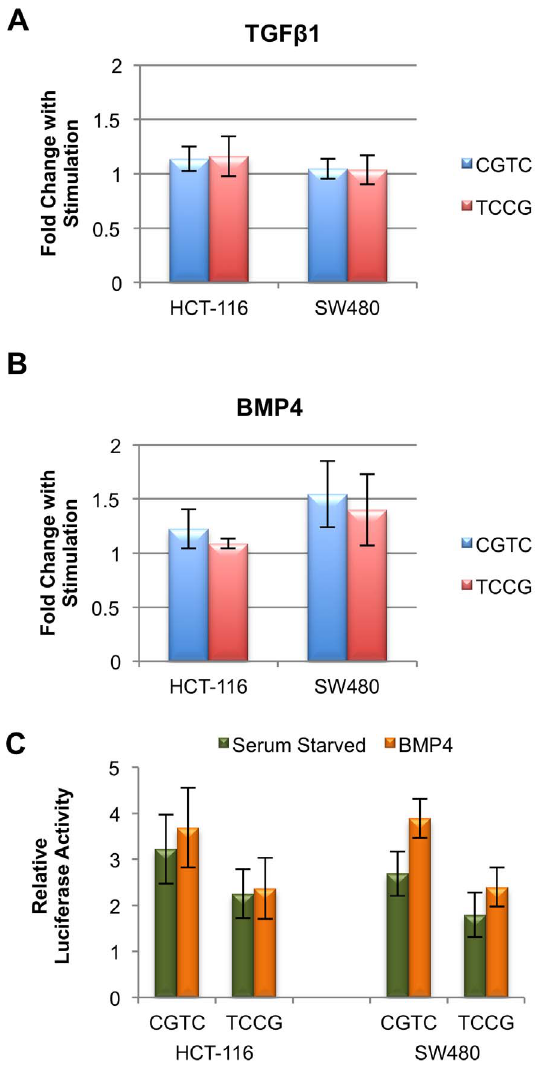
Figure 6. Fragment A Enhancer is responsive to BMP4 stimulation but not TGF b 1. ( A ) Enhancer activity was measured by luciferase assay for the fragment A containing the major (CGTC) and minor (TCCG) haplotypes in serum starved HCT-116 and SW480 cells incubated with TGF b 1 for 6 hours. Samples are plotted as a fold change in activity relative to non-treated cells on the same plate. ( B ) Enhancer activity was stimulated by 6 hours of BMP4 treatment for the CGTC haplotype in HCT-116 ( p = 4.14 6 10 2 3 ) and SW480 cells ( p =1.22 6 10 2 10 ). The TCCG haplotype in fragment A shows lower levels of stimulation, and only in SW480 ( p =1.61 6 10 2 6 ). (HCT-116 p =0.38). Effect of BMP is plotted as fold change over untreated samples for each haplotype on the same plate. ( C ) Enhancer activity comparison between the CGTC and TCCG haplotypes following BMP4 treatment. Relative luciferase activity was plotted for each haplotype in HCT-116 and SW480 using the same experimental dataset as (B).